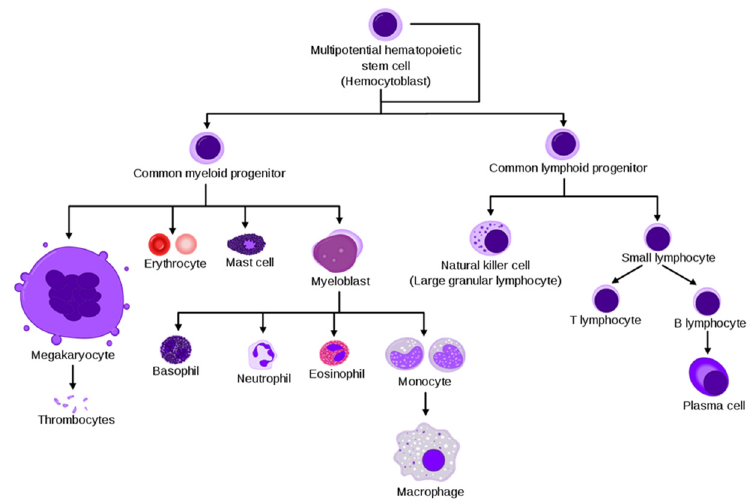
Figure 1. Simplified hematopoiesis hierarchy (Courtesy of Wikipedia).